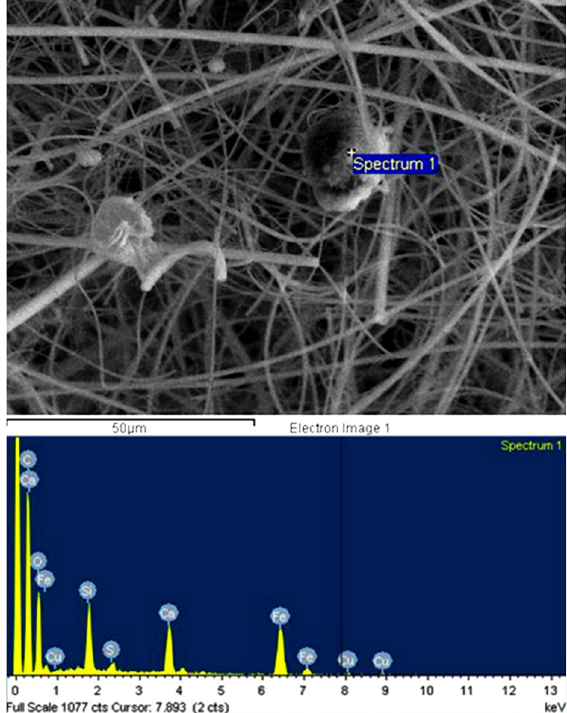
Figure 10. SEM micrograph and EDS spectrum of high-temperature emitted spherical